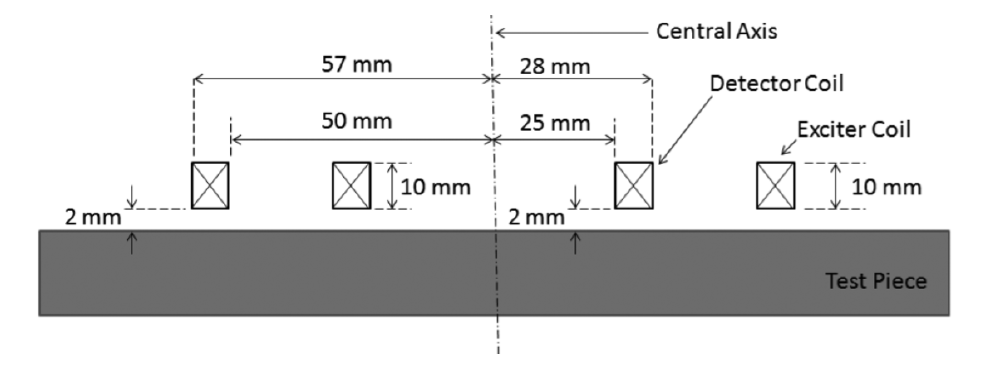
Figure 2. Cross sectional image of the used circular-shaped PEC sensor [27].